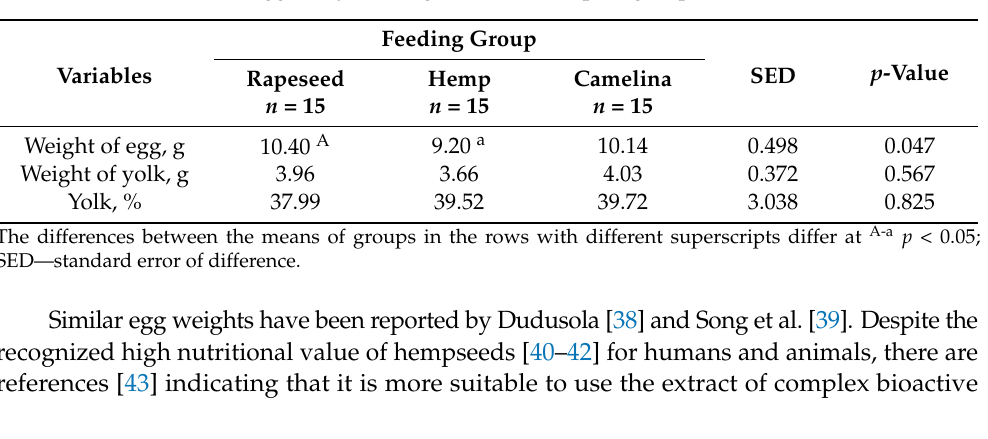
Table 3. Effects of diet on egg and yolk weight in different quail